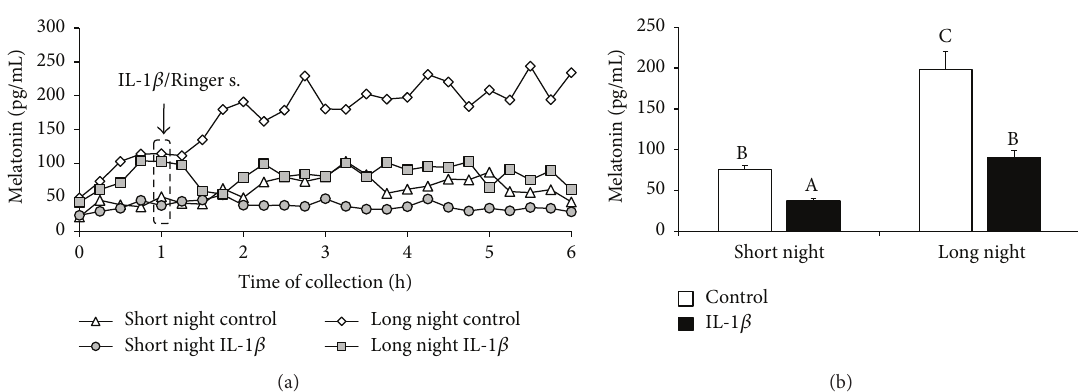
Figure 2: The effects of intracerebroventricular injection of interleukin- (IL-) 1 𝛽 (50 𝜇 g/animal) or Ringer’s solution (50 𝜇 L) on melatonin concentration in ewes taken during the short night (SN, May/June) and long night (LN, November/December) photoperiods. Experiments started one hour after sunset. (a) presents the temporal patterns of the mean concentration of circulating melatonin ( 𝑛 = 6 animals per group) in 15min samples. (b) depicts the mean ( ± SEM; 𝑛 = 6 animals per group) concentrations of melatonin for the period after IL-1 𝛽 or Ringer’s solution treatment (1 to 4 h) of ewes during the SN and LN photoperiods. Different capital letters indicate significant ( 𝑃 < 0.05 ) differences based on a two-way ANOVA followed by Tukey’s post hoc test.